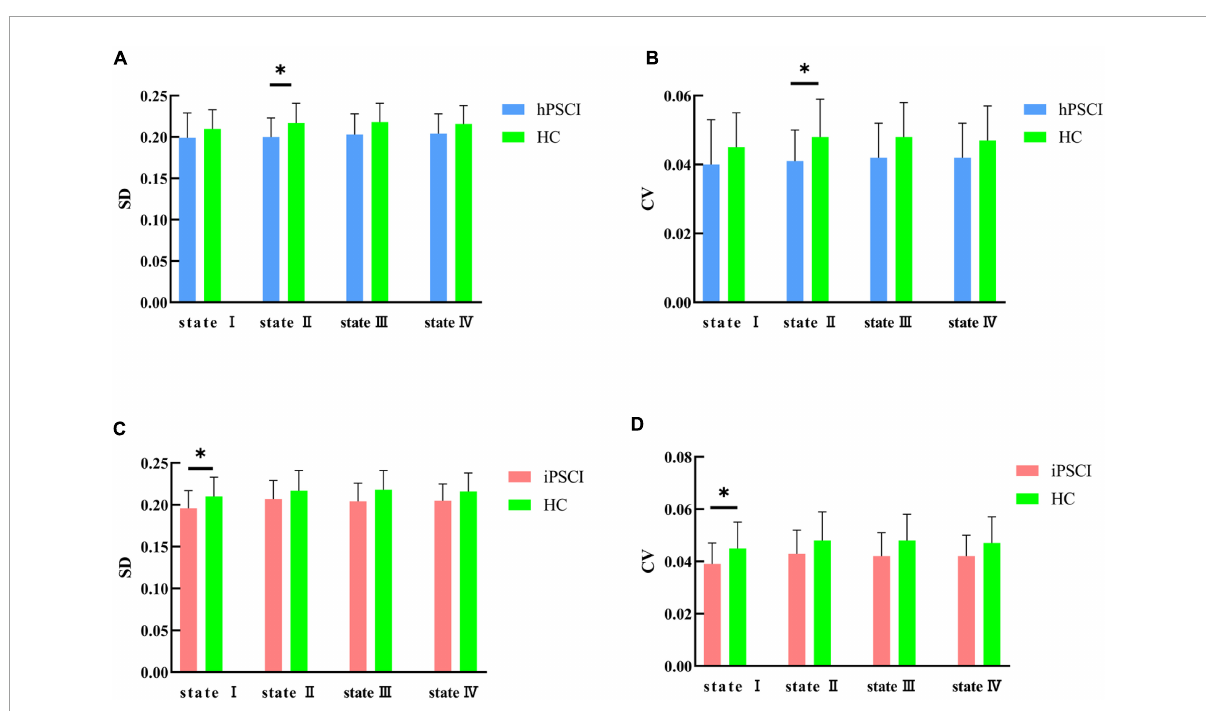
FIGURE5 SD and CV differences between groups. (A) SD difference between hPSCI patients and HC; (B) CV difference between hPSCI patients and HC; (C) SD difference between iPSCI patients and HC; (D) CV difference between iPSCI patients and HC. SD, standard deviation; CV, coefficient of variation; hPSCI, cognitive impairment group after hemorrhagic stroke; iPSCI, the cognitive impairment group after ischemic stroke; HC, health control group; ∗ P < 0.05. The error bars represent standard deviation of SD and